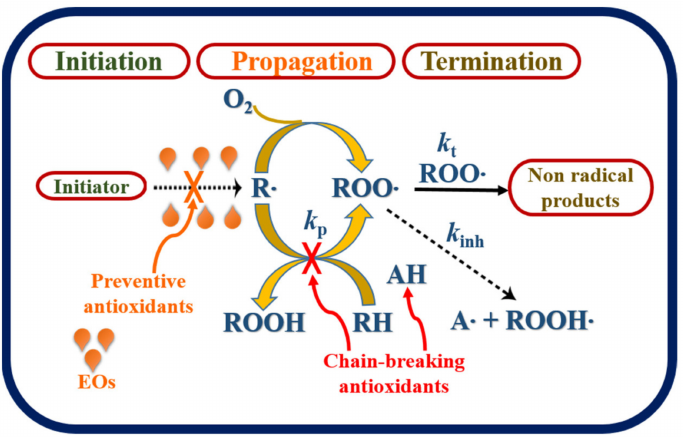
Figure 2. Proposed mechanism of hydrocarbon autoxidation and antioxidant properties of EOs. The typical three phases of free radical chain reactions, initiation, propagation, and termination are shown. RH represents a hydrocarbon, R · is an alkyl radical produced by the removal of a hydrogen atom from RH, ROO · is the peroxy radical formed by the reaction of R · with molecular oxygen; k p and k t are the propagation and termination rate constants, respectively, and k inh is the inhibition rate